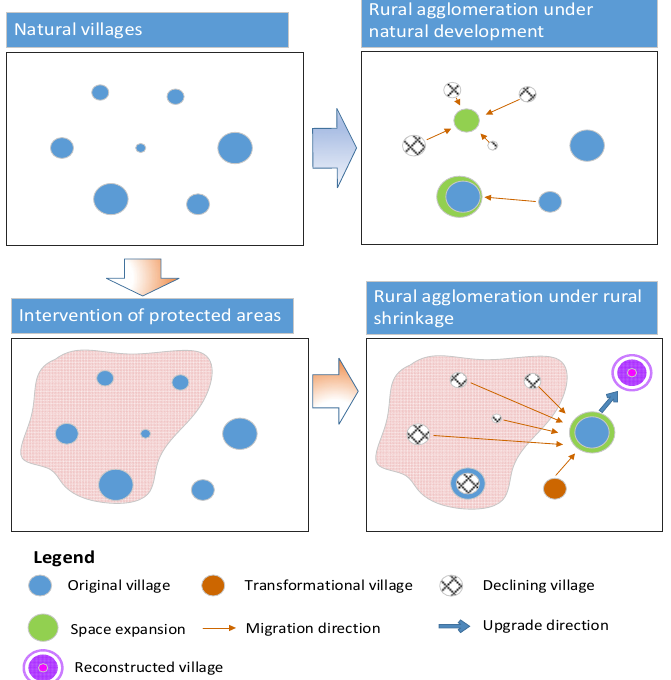
Figure 7. Comparison of rural shrinkage scenarios under natural development and protected land intervention.